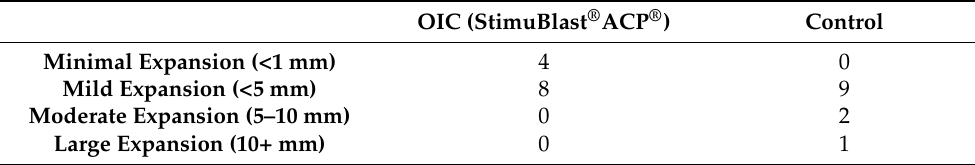
Table 4. Summary of tibial tunnel expansion by categorical